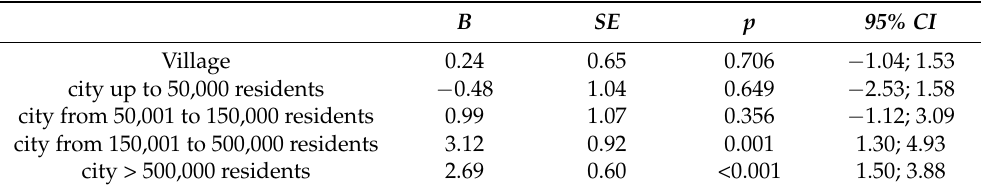
Table 7. Simple effects coefficients for the place of residence in the context of the relationship between awareness of the possibility of a repetition of a pandemic situation and stress. B SE p 95% CI Village 0.24 0.65 0.706 − 1.04; 1.53 city up to 50,000 residents − 0.48 1.04 0.649 − 2.53; 1.58 city from 50,001 to 150,000 residents 0.99 1.07 0.356 − 1.12; 3.09 city from 150,001 to 500,000 residents 3.12 0.92 0.001 1.30; 4.93 city > 500,000 residents 2.69 0.60 <0.001 1.50;